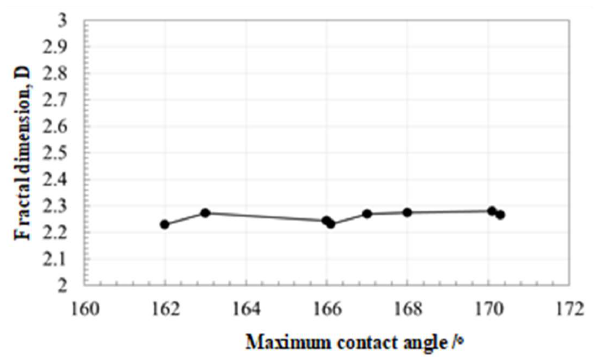
Figure 7. Relationship of the fractal dimension to the measured maximum contact angle.